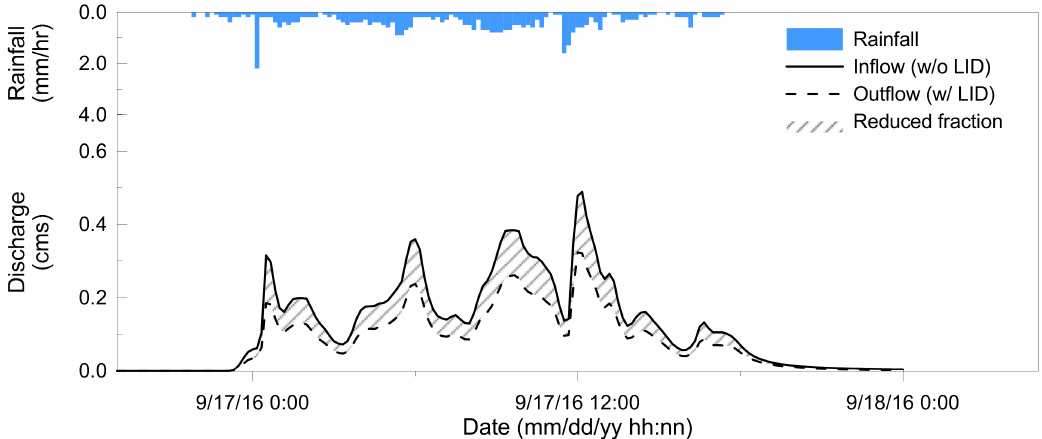
Figure 6. Hydrograph results of the total drainage area: In this figure, the hydrograph consists of inflow, outflow, and reduced fraction. The inflow indicates a case without LID facilities and the outflow is the other case with LID facilities. The reduced fraction means a portion of reduced runoff by LID